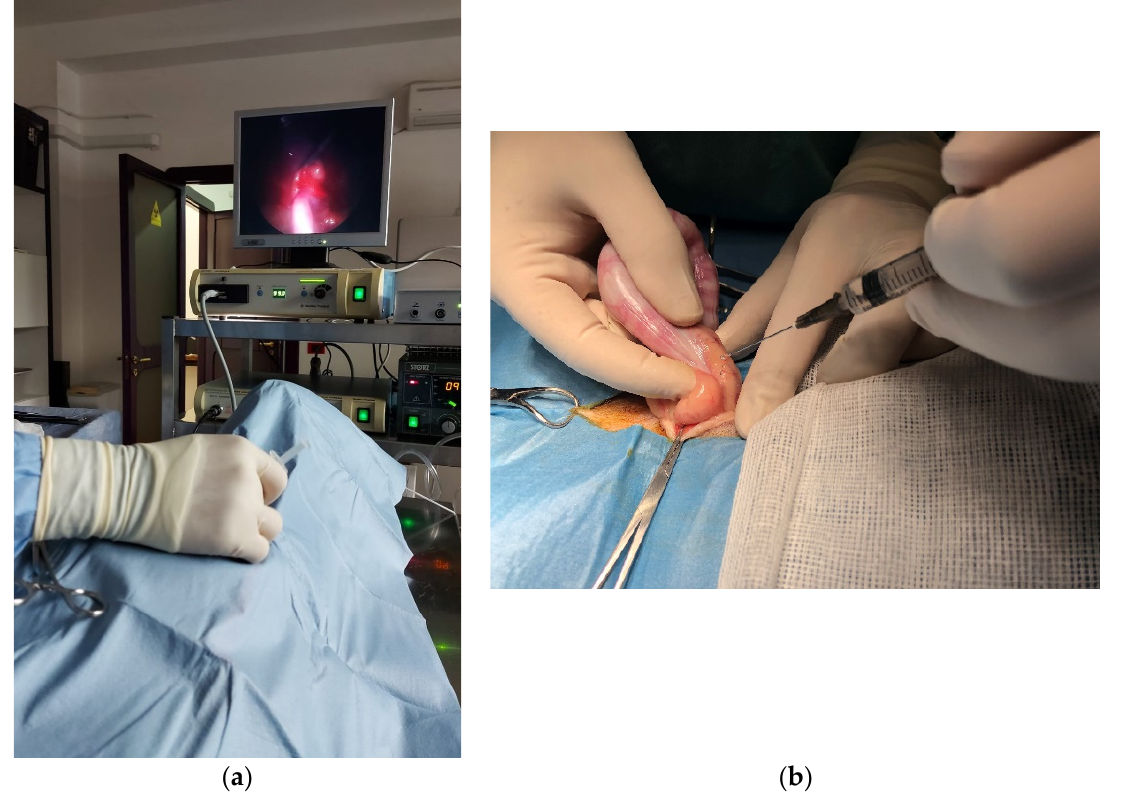
Figure 1. Lidocaine infiltration on ovarian pedicle during video-assisted OVH ( a ) and open surgery ( b